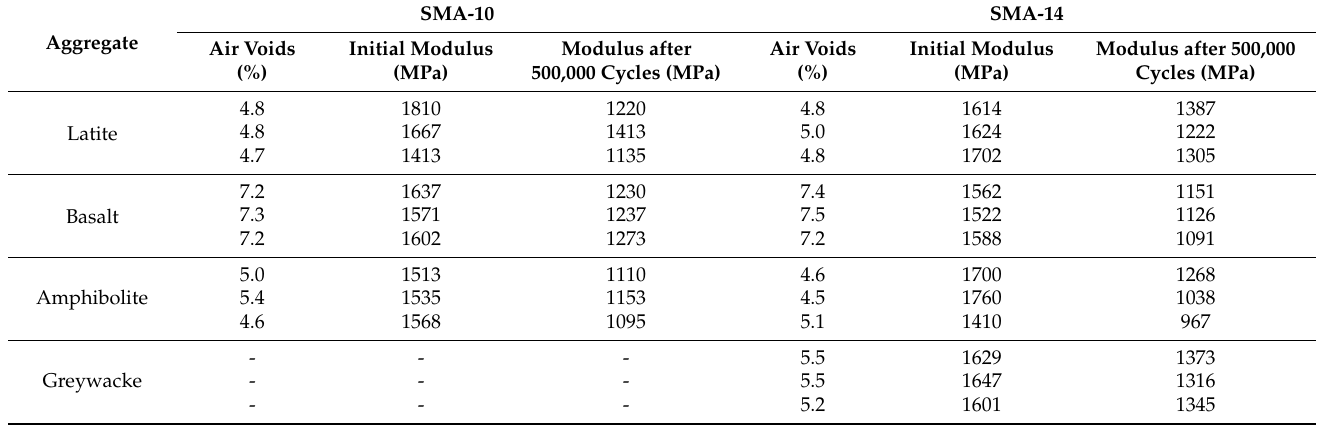
Table 10. Laboratory fatigue results (triplicate).